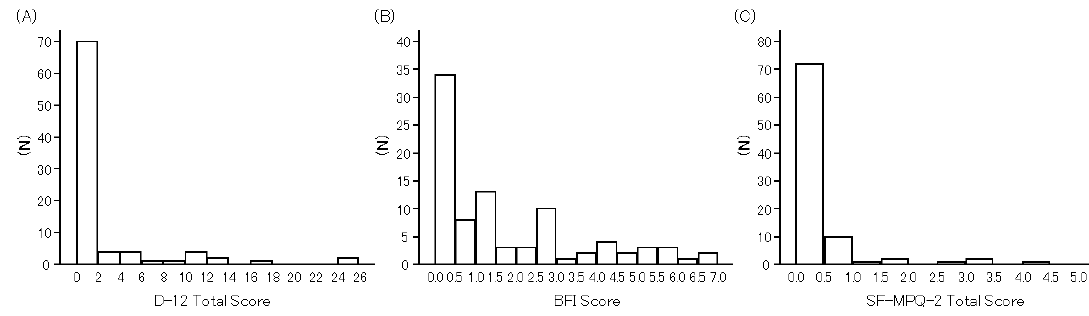
Figure 1. Frequency distribution histograms of the Dyspnoea-12 (D-12) Total Score ( A ), the Brief Fatigue Inventory (BFI) Score ( B ) and revised Short–Form McGill Pain Questionnaire 2 (SF-MPQ-2) Total Score ( C ) in 89 subjects with COPD. The D-12 is designed for measuring dyspnoea, BFI for fatigue and SF-MPQ-2 for pain. Higher scores in all the tools included herein indicate more severe impairment. The scores were all skewed toward the milder end of the respective scales.